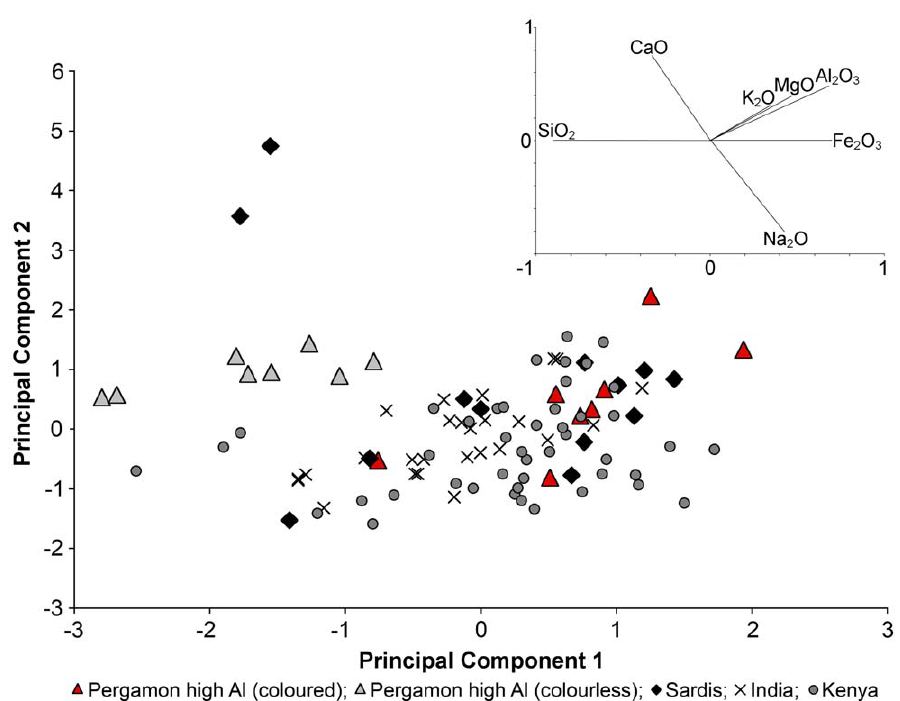
Figure 6. Principal component analysis of the major and minor elements. The high alumina glasses from Pergamon (colourless and pinkish samples represented as grey triangles; coloured samples shown as red triangles) were compared with data sets from mineral soda high alumina glasses from Sardis (black diamonds [36] and by courtesy of Laure Dussubieux), India (crosses) and Kenya (circles)[40], using principal component analysis (PCA) of the major and minor base glass elements (SiO 2 , Na 2 O, CaO, Al 2 O 3 , MgO, K 2 O, FeO). The loading vectors are shown to illustrate the multi-dimensional group structures (inset).